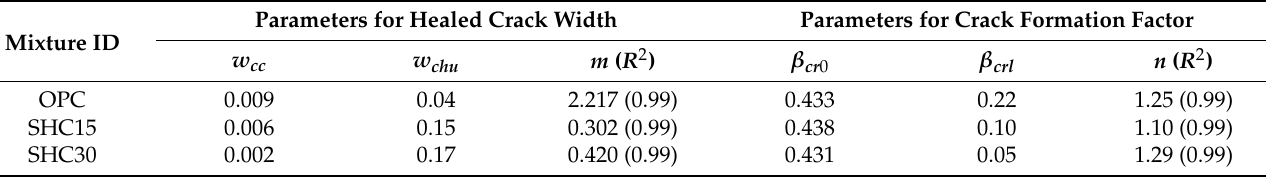
Table 3. Parameters for healed crack width and crack formation